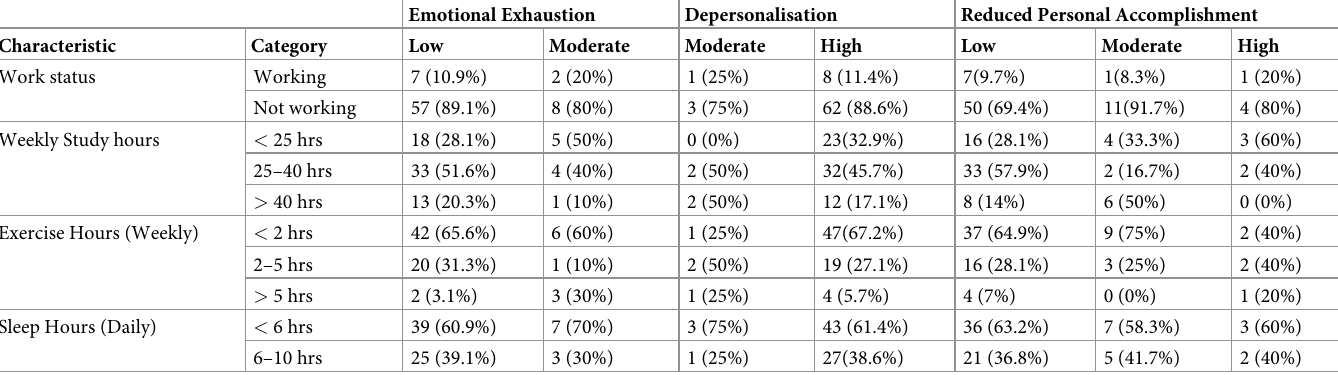
Table 6. Results on student practices and burnout